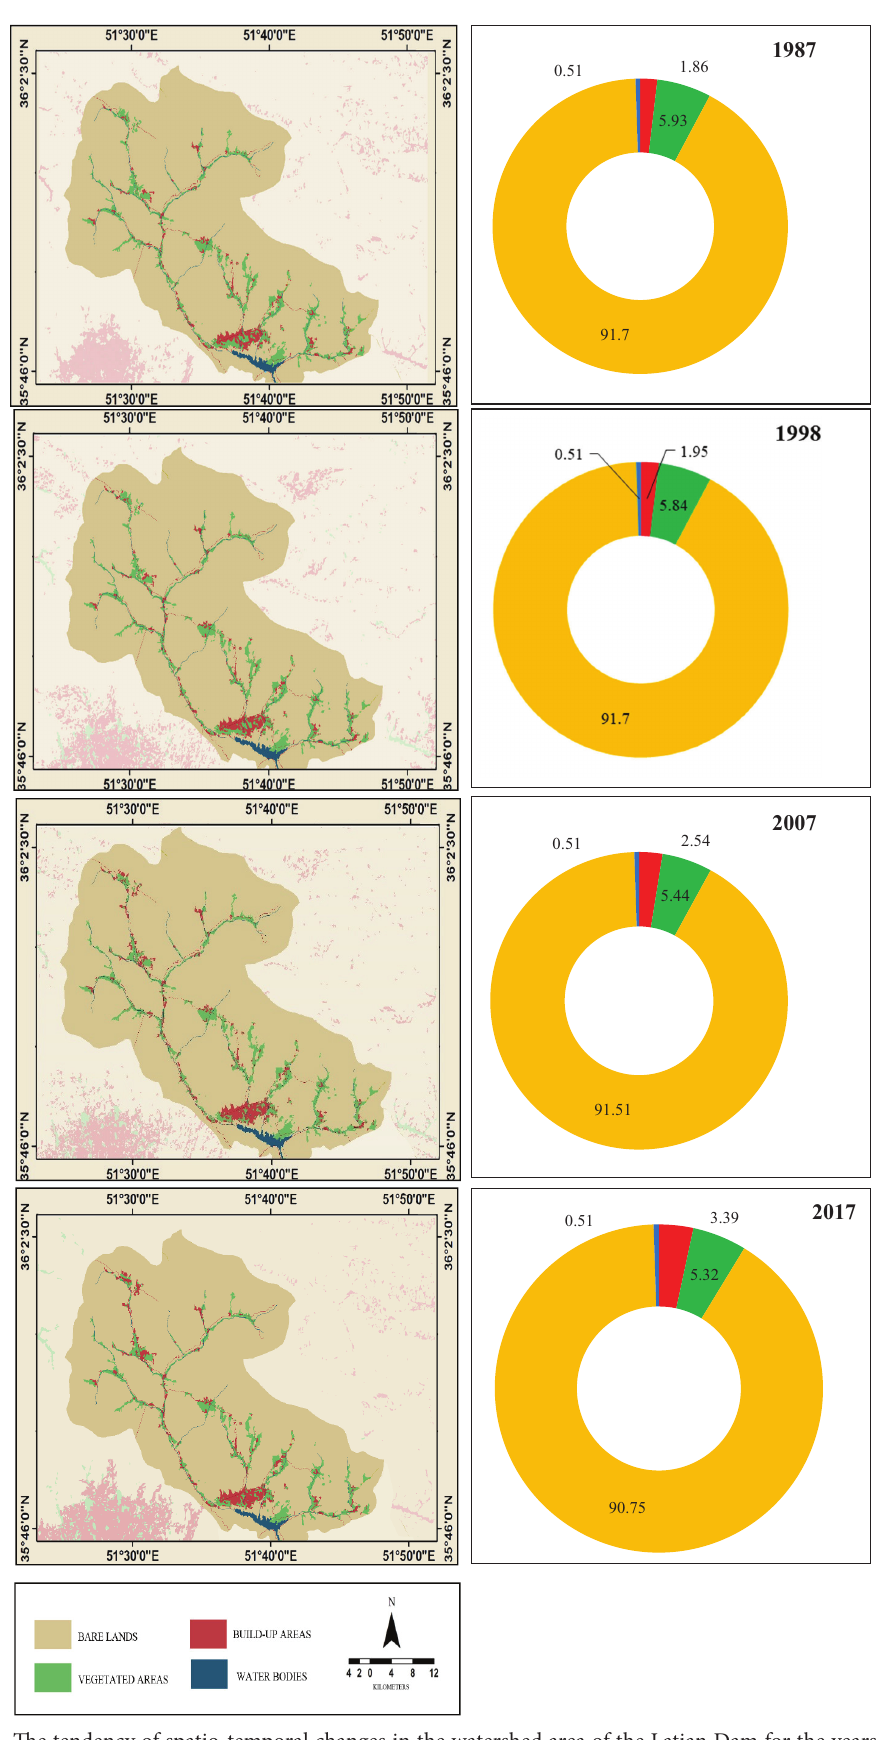
Figure 3. The tendency of spatio-temporal changes in the watershed area of the Latian Dam for the years 1987 to